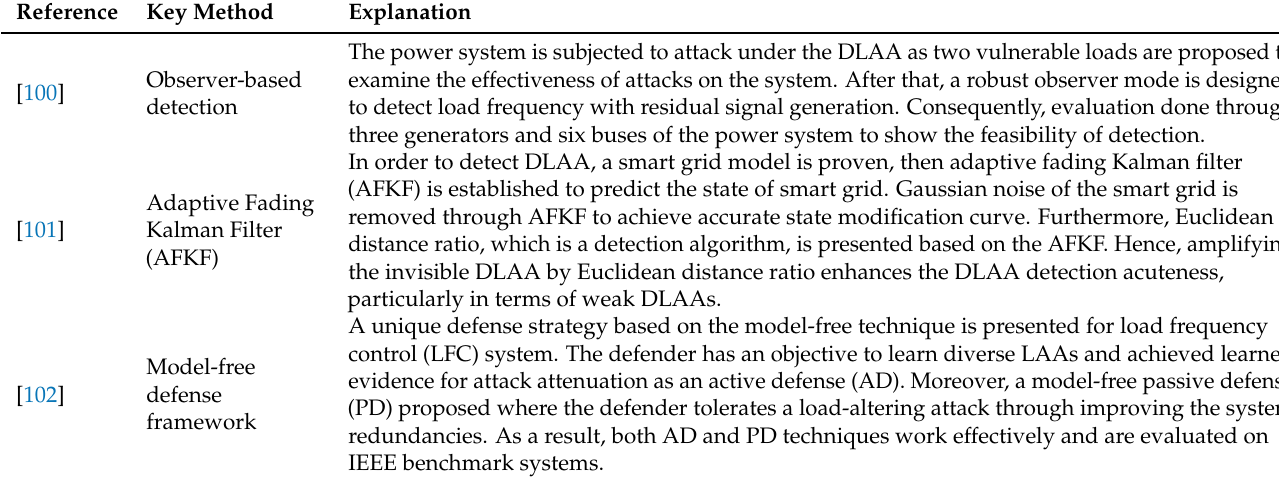
Table 6. Methods and countermeasures to defend against LAA